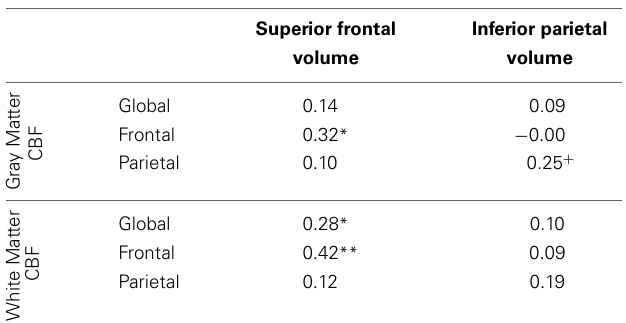
Table 5 | Partial correlations between CBF and normalized superior frontal and inferior parietal anatomical volumes, controlling for